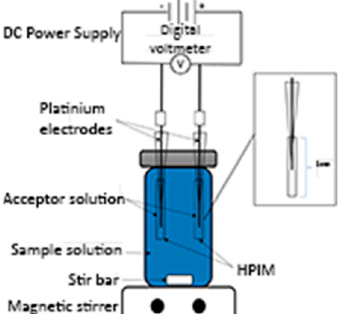
Figure 1. Simultaneous EME across HPIM set